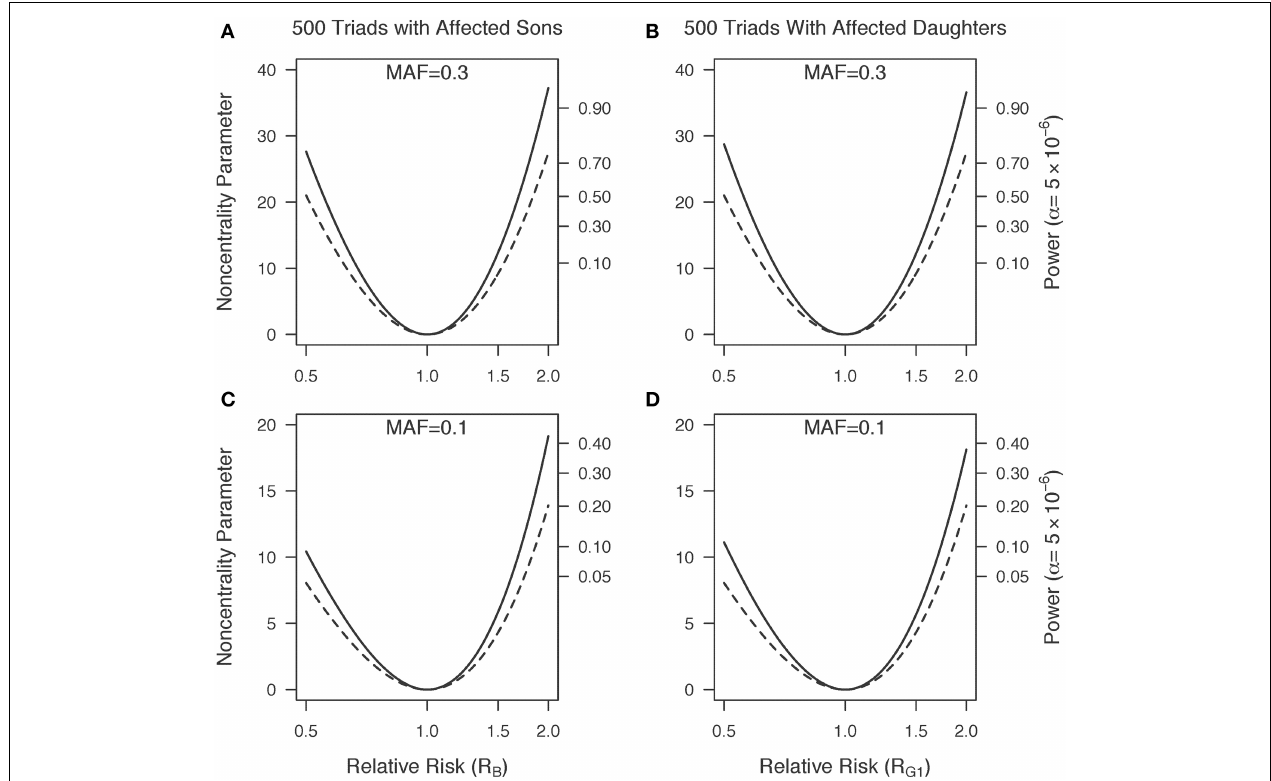
FIGURE 2 | Non-centrality parameter estimates as a function of relative risk. (A,C) Five hundred triads with affected sons and (B,D) 500 triads with affected daughters. Minor allele frequencies of 0.3 (A,B) and 0.1 (C,D) are used. Solid lines represents PIX-LRT results.